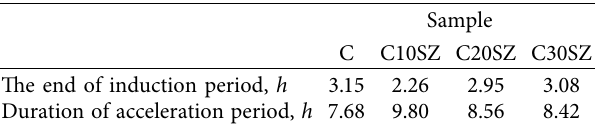
Figure 3: Total heat of hydration of the Portland cement samples without and with SZ. Table 3: The end of induction period and duration of acceleration period during hydration processes.